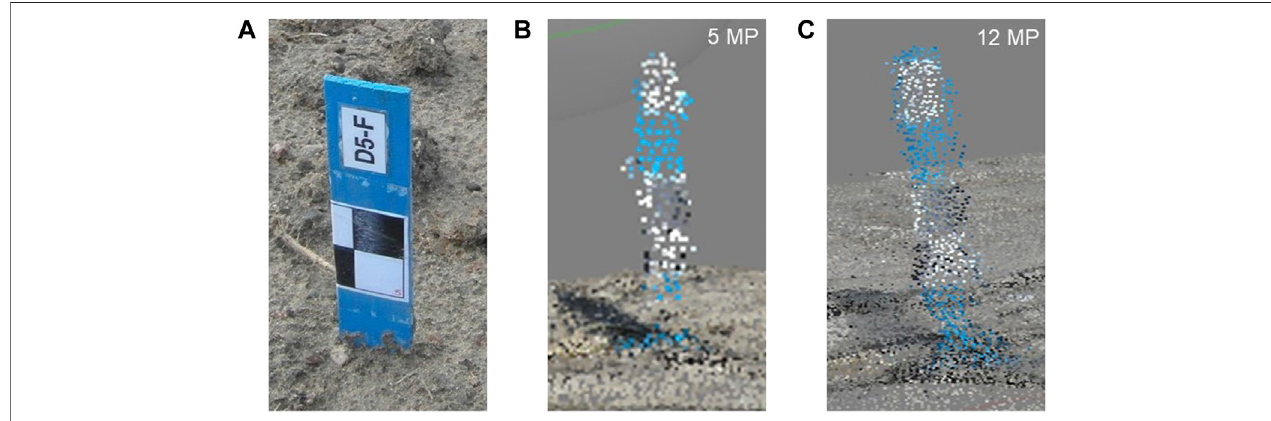
FIGURE2|(A) Examplephotoofagroundcontrolpoint(GCP)attheplotsurfaceandpointcloudsgeneratedbyphotostakenwitharesolutionof (B) 5 MP,and (C) 12